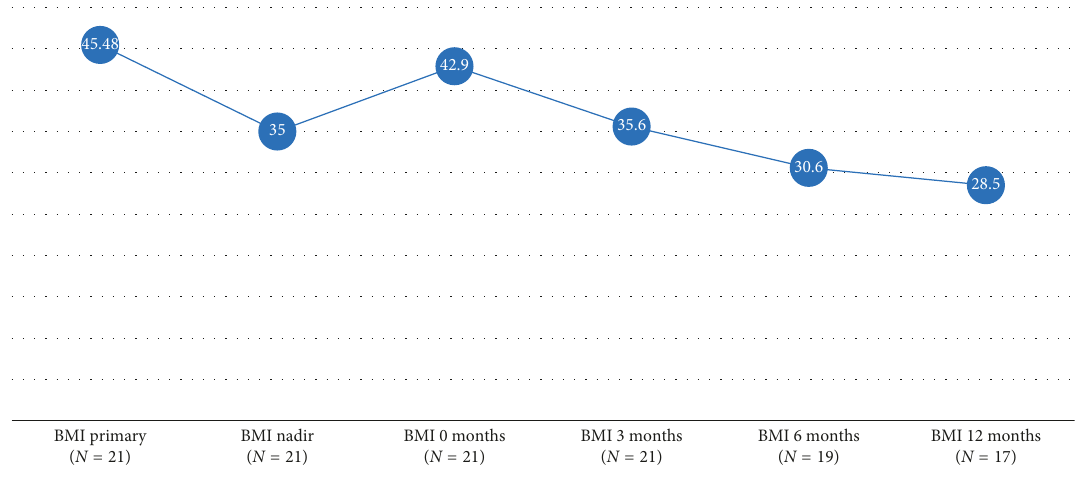
Figure 4: Evolution of body mass index (BMI) from the primary operation through the resectional